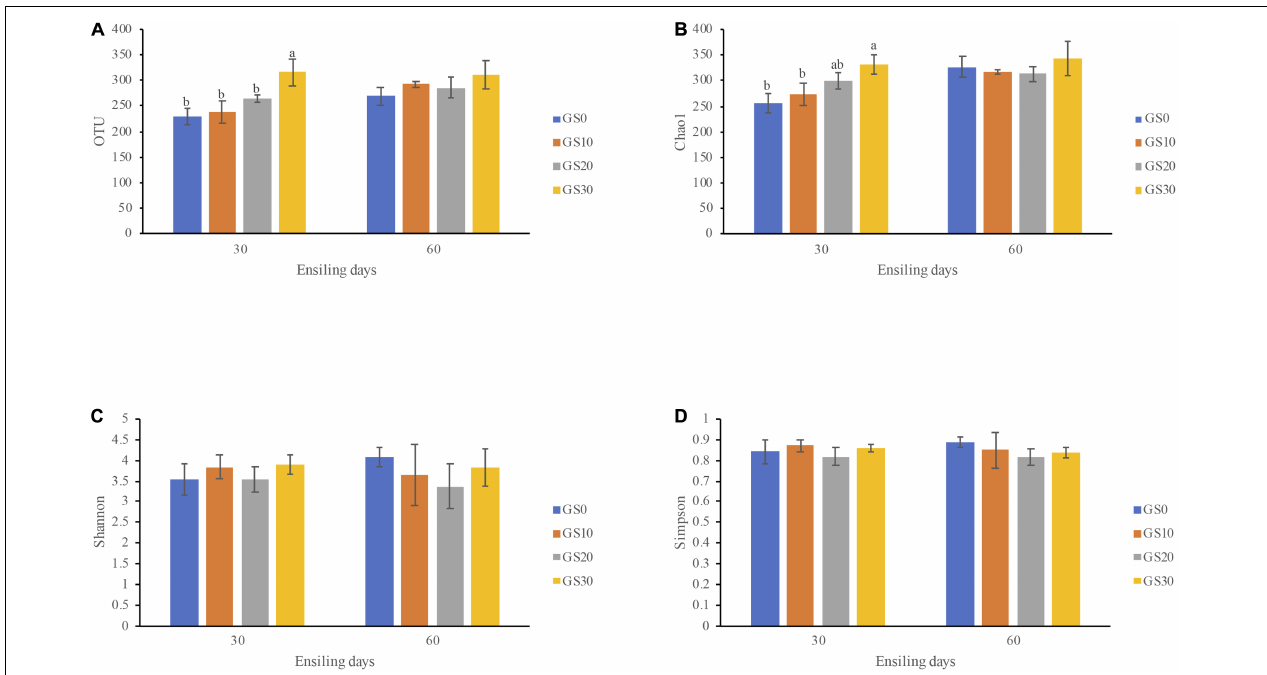
FIGURE 2 | Alpha diversity indices of bacterial community including OTU (A) , Chao1 (B) , Shannon (C) , and Simpson (D) of Pennisetum hydridum ensiled with garlic skin (GS0, 100 wt% Pennisetum hydridum ; GS10, 90 wt% Pennisetum hydridum + 10 wt% garlic skin; GS20, 80 wt% Pennisetum hydridum + 20 wt% garlic skin; GS30, 70 wt% Pennisetum hydridum + 30 wt% garlic skin). Different letters indicate a significant difference ( P <